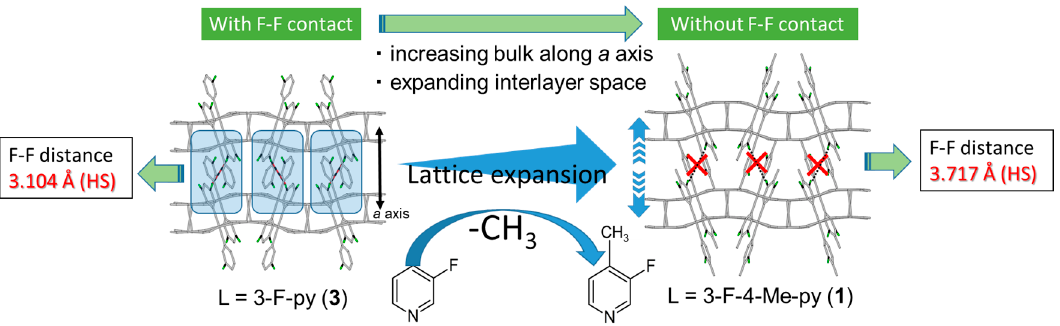
Scheme 2. Representation of the lattice expansion with the addition of the 4-position substituent. Blue highlighted box shows the F···F interactions (black and red dotted line).